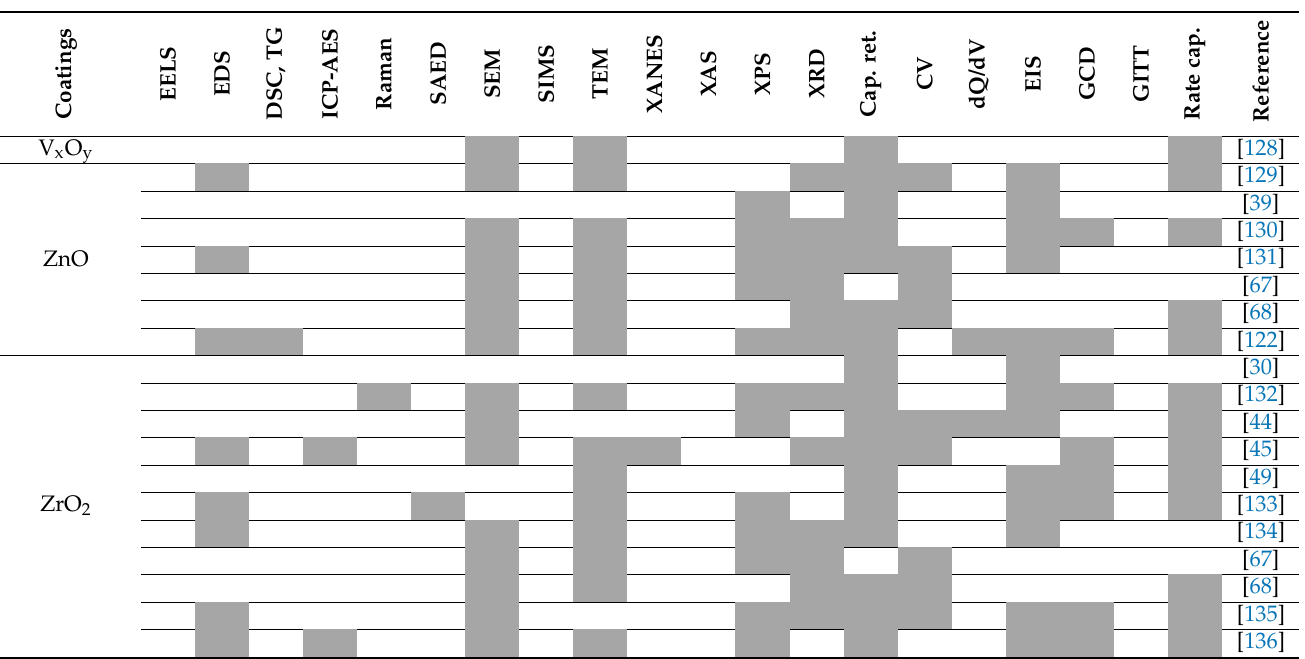
Table A2. Selectable equivalent circuits in impedance spectroscopy studies.